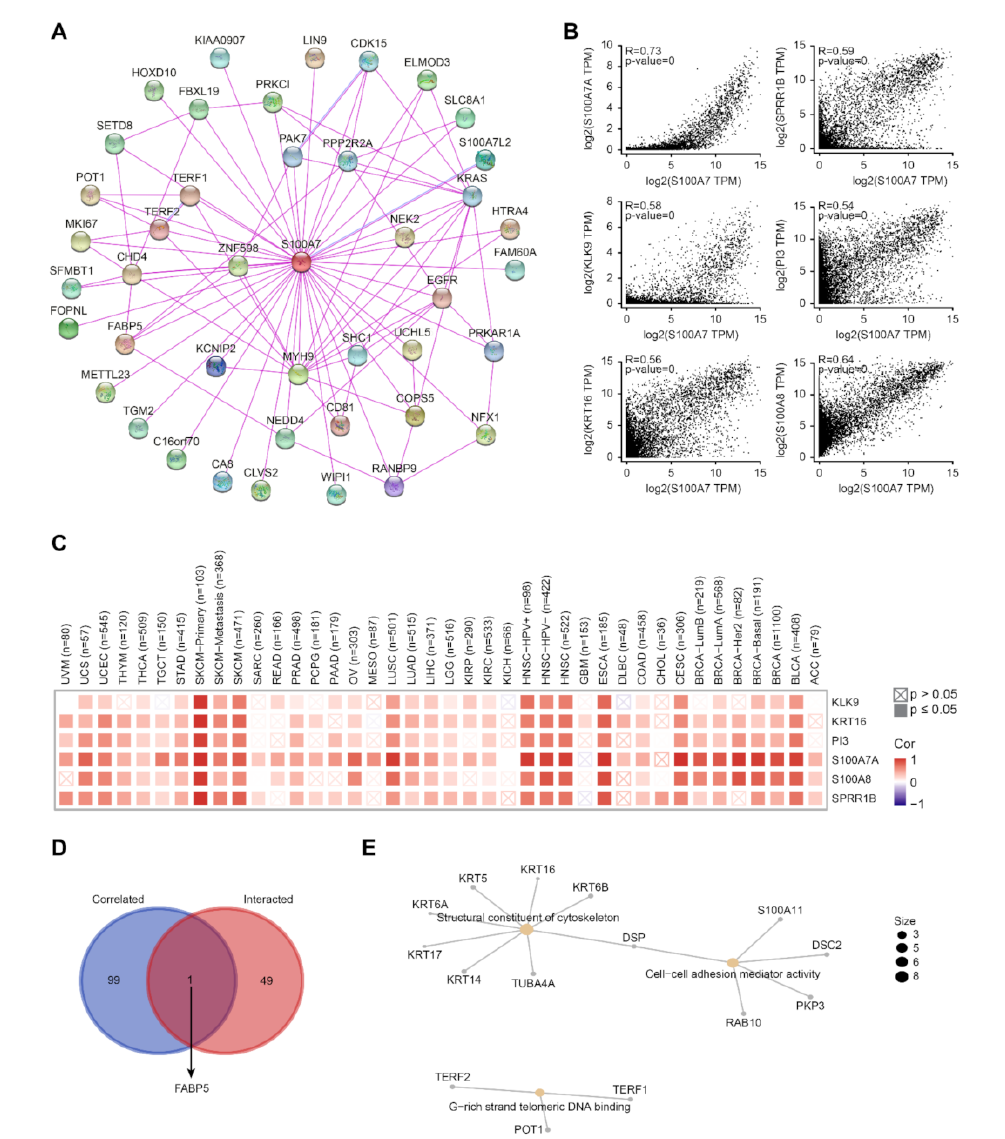
Figure 6. Enrichment analysis of S100A7-related gene. ( A ) The interaction of 50 S100A7-binding proteins. ( B ) The expression correlation between S100A7 and selected target genes, including S100A7, SPRR1B, KLK9, PI3, KRT16 and S100A8. ( C ) Heatmap data of the correlation between S100A7